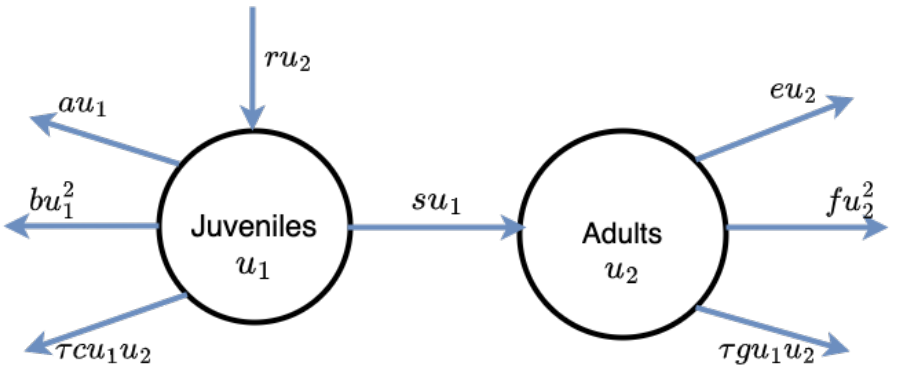
Figure 1. Illustrative diagram of the dynamics of a population structured in two stages, where u 1 is the density of the juveniles and u 2 is the density of the